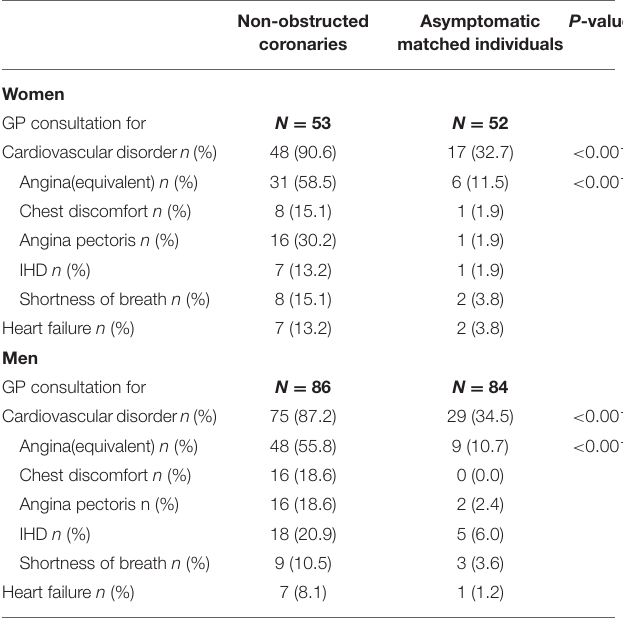
TABLE 4 | Cardiovascular consultations in women and men with non-obstructed coronary arteries vs. asymptomatic individuals.